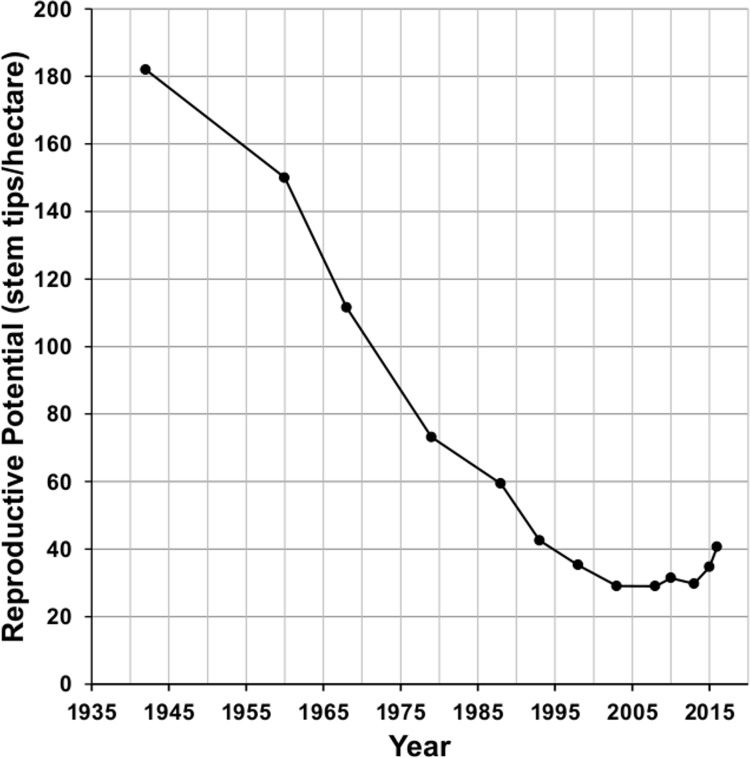
Saguaro reproductive potential from 1942 to 2016.